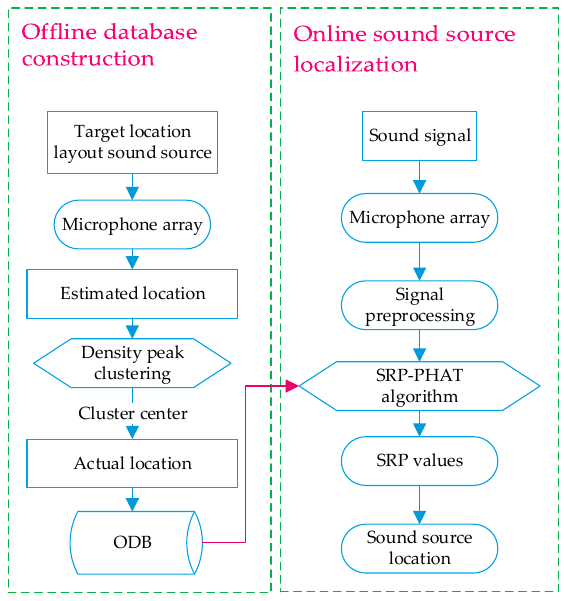
Figure 1. ODB-SRP-PHAT flowchart.